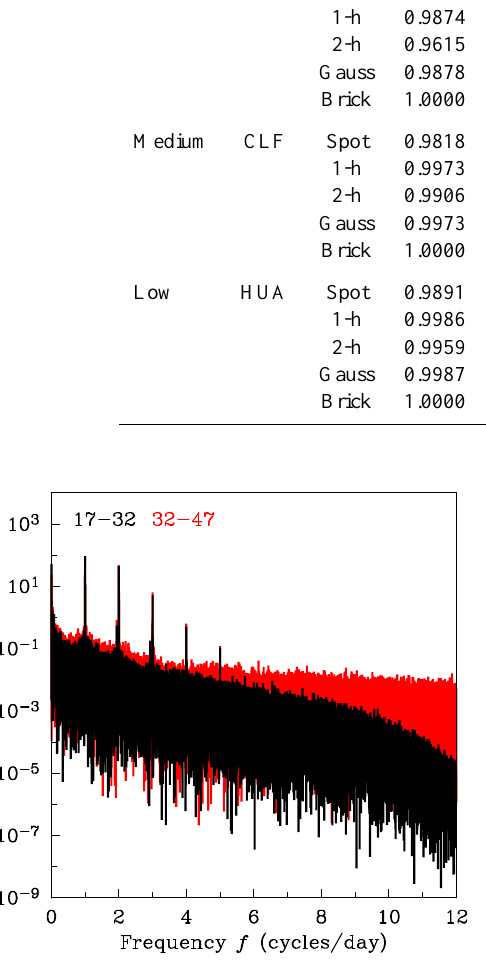
Fig. 8. Comparison of power spectral density P H (f ) as a func- tion of frequency f for historical hourly ESK- H data obtained from WDC-CE, 1917.0–1932.0 (black) and 1932.0–1947.0 (red).